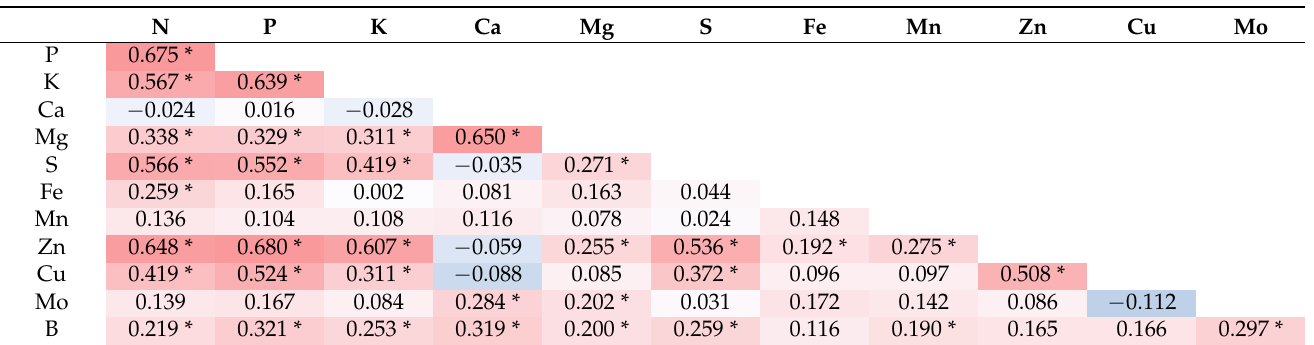
Table 2. Pearson’s correlation matrix between nutrient concentrations in strawberry leaves in Latvia,